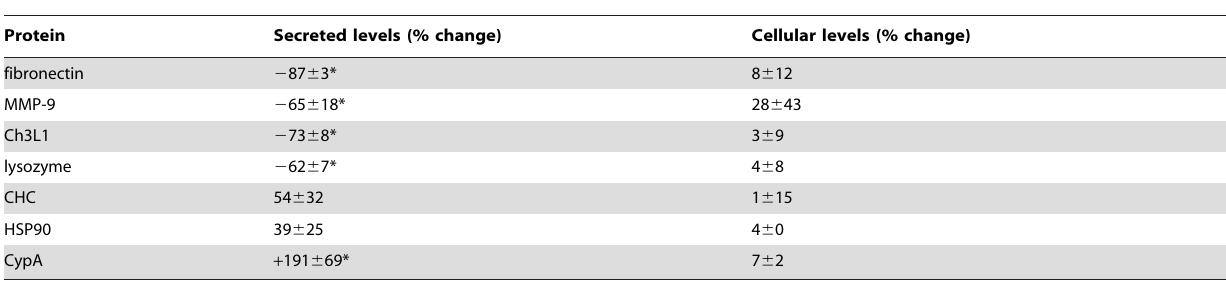
Table 3. Effect of MiTMAB on macrophage protein secretion.